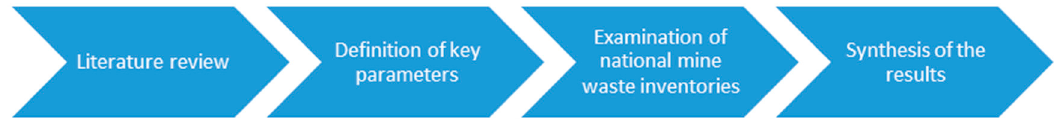
Figure 2. Methodological approach and the different steps conducted in this study.